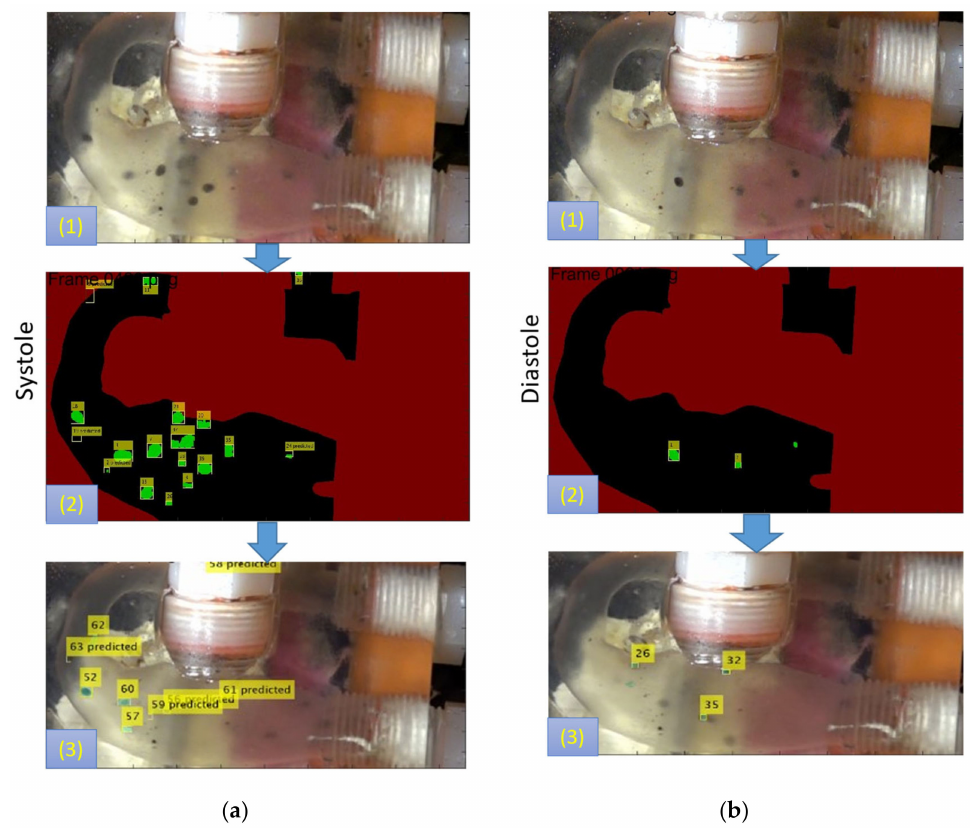
Figure 19. The figure shows the Foreground subtraction (step 1) with the blob detection (step 2) and the multi-objective Kalman filter-based tracking process (step 3) of the particles in the MPA conduit during the ( a ) systole and ( b ) diastole phase of the cardiac